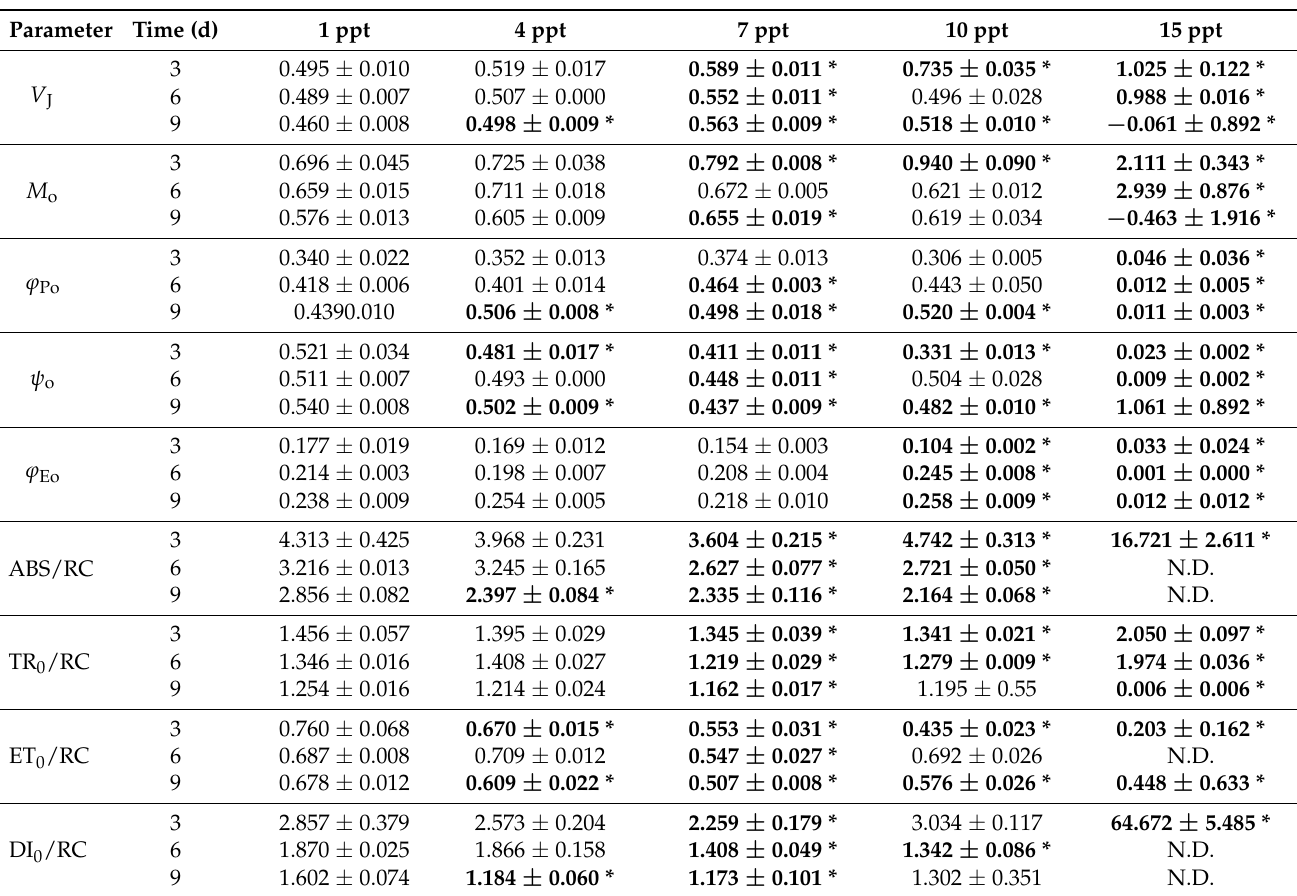
Table 1. Chlorophyll a fluorescence parameters of M . aeruginosa under different salinity stresses on days 3, 6 and 9. Bold letters marked with ‘*’ indicated significant differences compared to the control (ANOVA, p < 0.05); “N.D.” indicated not